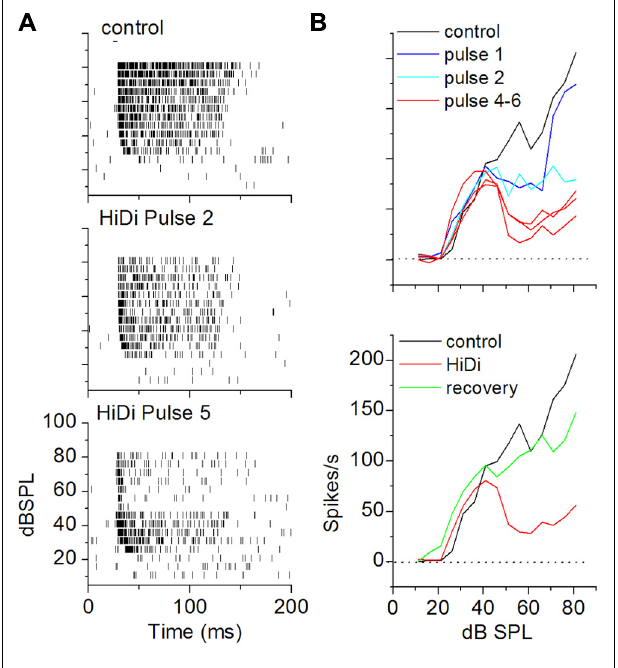
FIGURE 6 | Criterion for a complete separation of mono- and polysynaptic influences on firing rate in vivo . (A) Achievement of steady state RIFs in HiDi. Raster plots in control (top) and after the second (middle) and fifth (bottom) pulse of 2.5 HiDi indicate gradually greater decrease in firing with successive HiDi pulses. (B) Top: change in the RIF with repeated HiDi application. In this cell, four HiDi pulses (each pulse was 500 ms, 8 psi) were required to reach a steady-state RIF. RIFs measured after the fourth, fifth and sixth HiDi pulses are superimposed. Bottom: recovery from HiDi (blue trace) ∼ 6 min after the application was